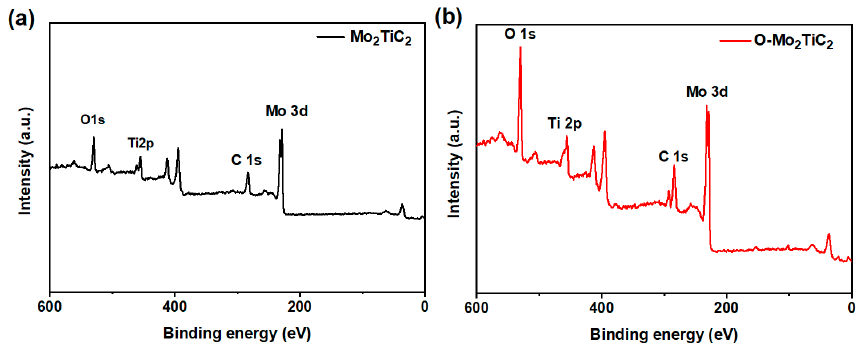
Figure 3. ( a , b ) XPS survey spectra of Mo 2 TiC 2 and O-Mo 2 TiC 2 .